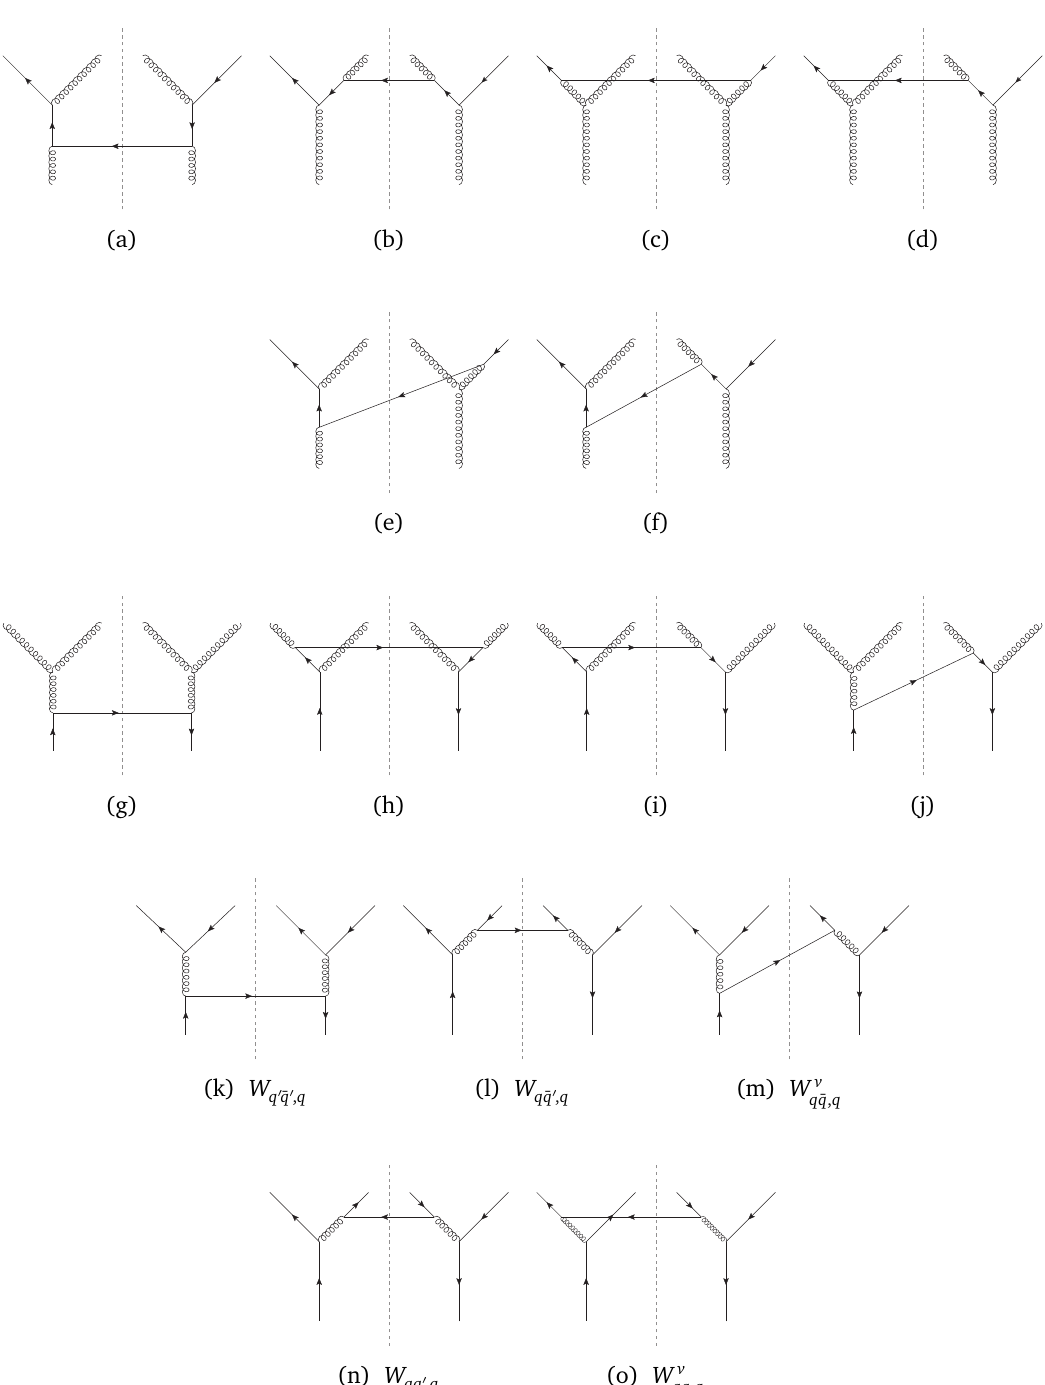
Figure 2: Real graphs for NLO channels. The association of parton lines is as in figure